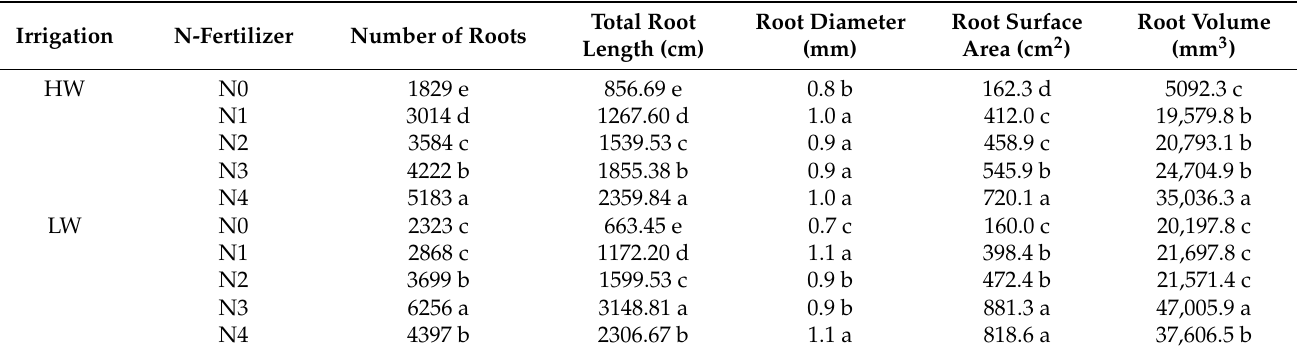
Table 3. Effects of irrigation and nitrogen application on number of roots, total root length, acreage diameter and surface